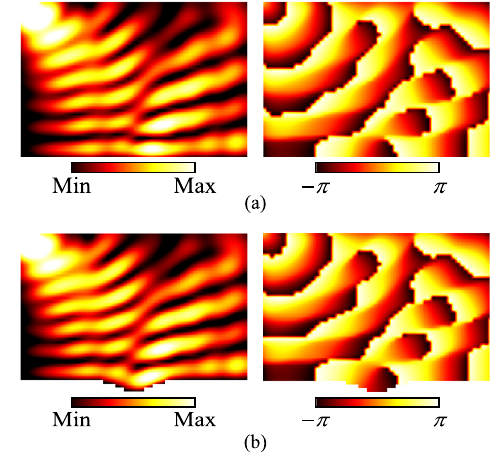
Fig. 25. Calculated complex voltage distributions corresponding to measured results in Figure 24. Left: Amplitude. Right: Phase. (a) With the groove illusion medium. (b) With the original groove.